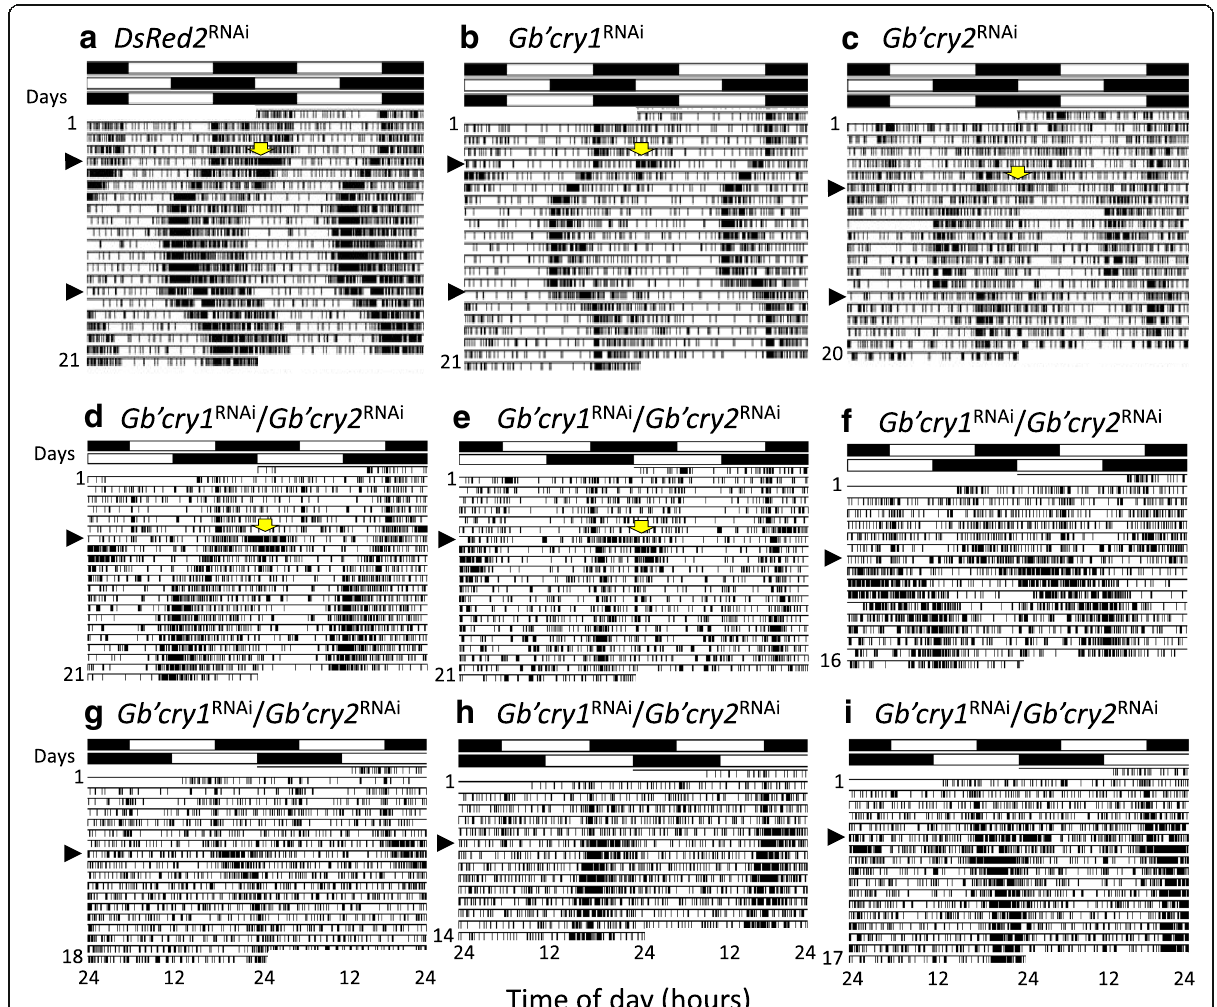
Fig. 1 Entrainment of the locomotor rhythm to LD12:12 in DsRed2 RNAi ( a ), Gb ’ cry1 RNAi ( b ), Gb ’ cry2 RNAi ( c ), and Gb ’ cry1 RNAi /Gb ’ cry2 RNAi crickets ( Gryllus bimaculatus ) ( d - i ). Light cycles were advanced or delayed by 6 h on the day indicated by an arrowhead on the left side of the actograms. White and black bars above the actograms indicate light (white) and dark (black) cycles. Yellow arrows indicate the light induced activity at light-on after a 6 h phase advance of the light cycle. Transient cycles were shorter in Gb ’ cry1 RNAi and Gb ’ cry2 RNAi crickets than in the control ( DsRed2 RNAi ) crickets, but were longer in Gb ’ cry1 RNAi /Gb ’ cry2 RNAi crickets. Some of the Gb ’ cry1 RNAi /Gb ’ cry2 RNAi crickets ( e , h, i ) apparently lost entrainability